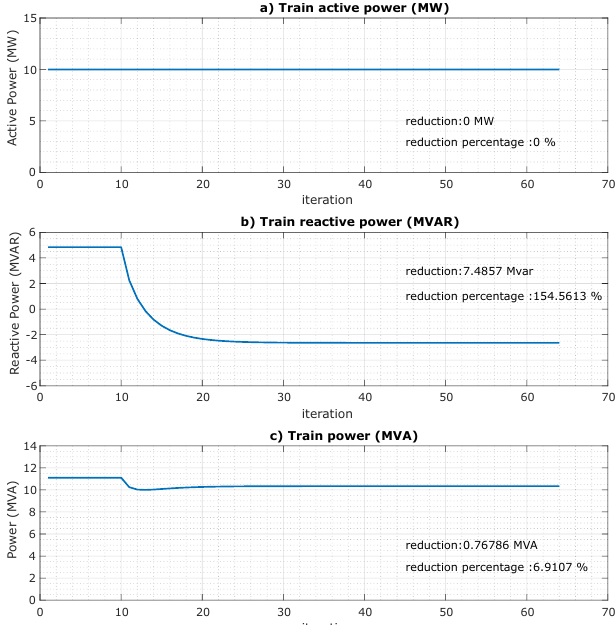
Figure 8. Illustration of algorithm evolution for reactive power compensation: ( a ) evolution of train active power; ( b ) evolution of train reactive power; ( c ) evolution of train apparent power.